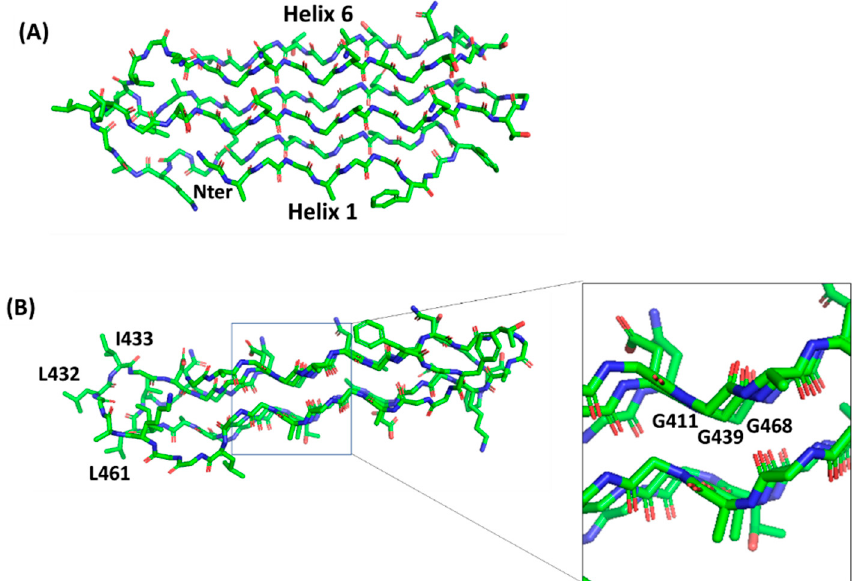
Figure 5. Stick representation of the homology model of the PG II sandwich domain PG II 4, computed using the structure of sfAFP as a template (pdb code 2pne). The front view ( A ) shows the six PG II helices, whereas the side view ( B ) shows the localization of hydrophobic residues (e.g., L432, I433, L461) on the lateral loops. The inset shows glycine residues pointing inside and stabilizing the tightly packed PG II helices.